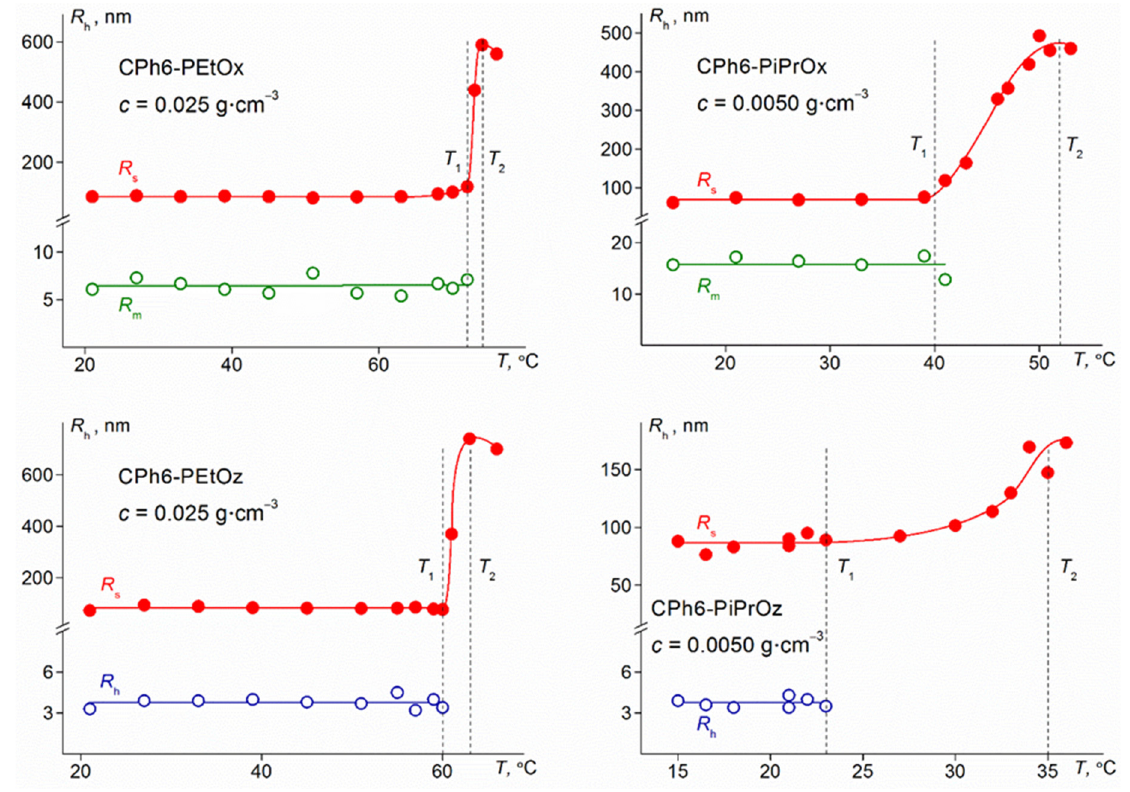
Figure 6. Temperature dependences of hydrodynamic radii R h of scattering objects for aqueous solutions of star-shaped pseudo-polypeptoids.